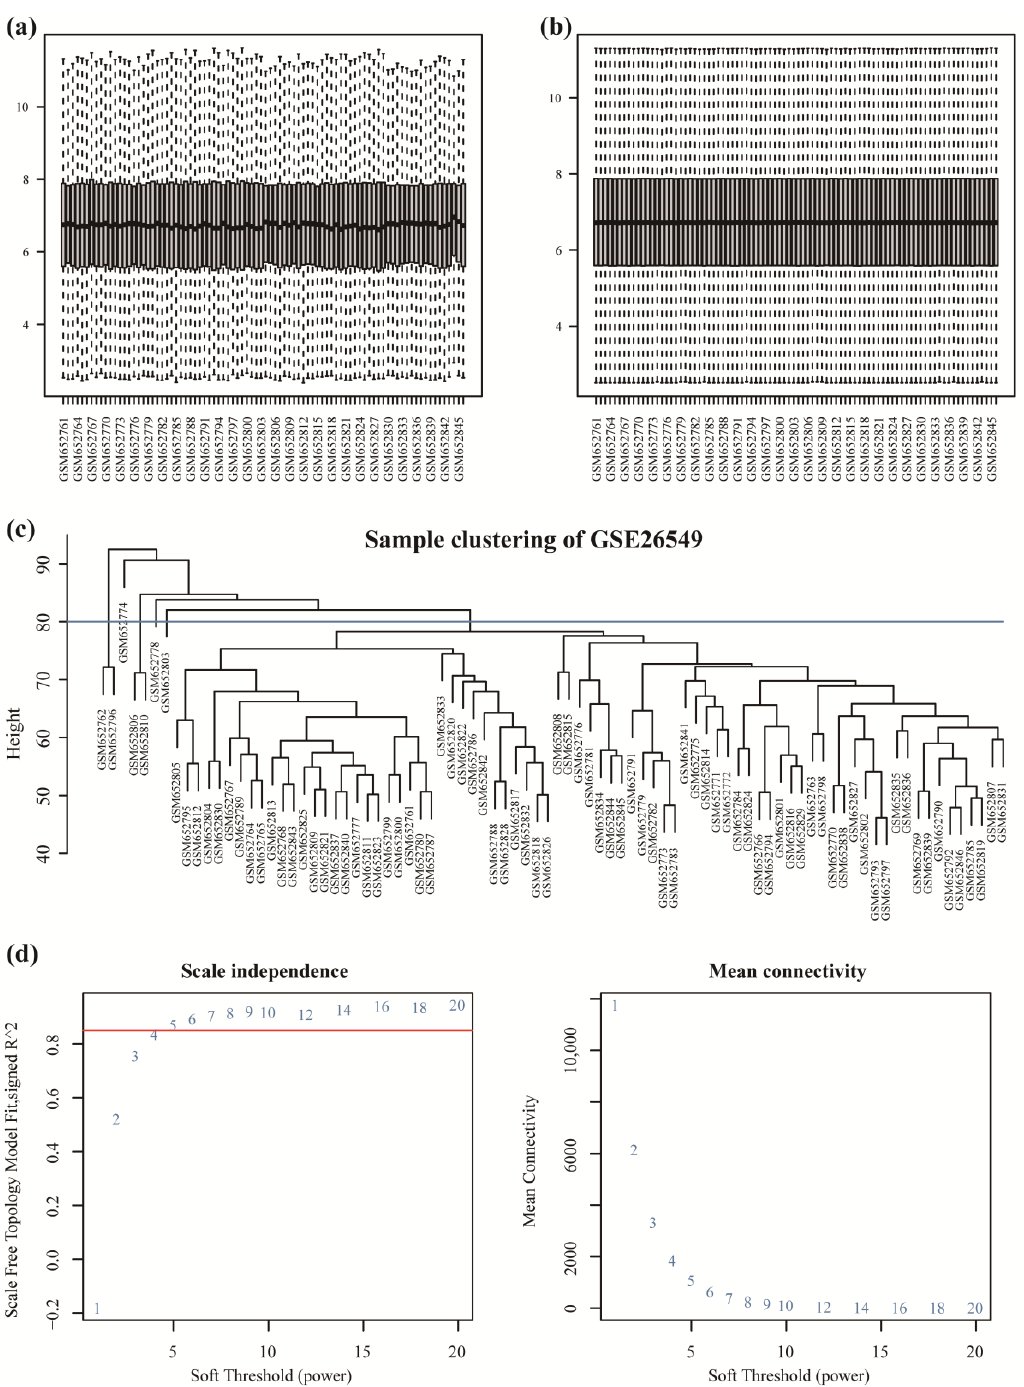
Figure 1. WGCNA of gene modules associated with OL. ( a ) Data distribution before the correction. ( b ) Data distribution after the correction. ( c ) Sample clustering tree. ( d ) The soft threshold value was calculated using the pickSoftTreshold function.